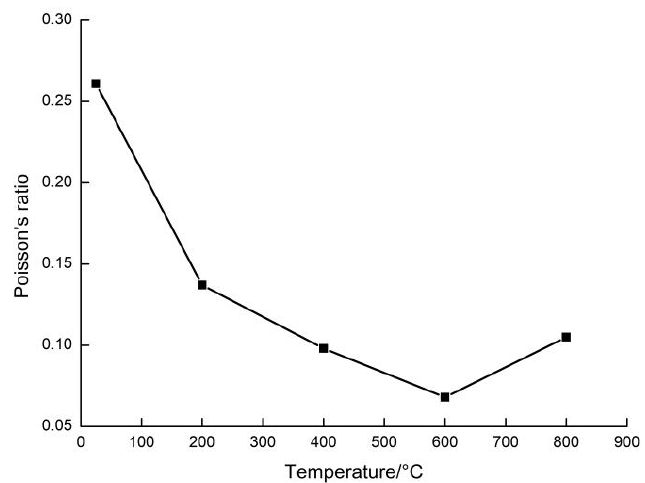
Figure 7. The relationship between Poisson’s ratio and temperature for sandstone.